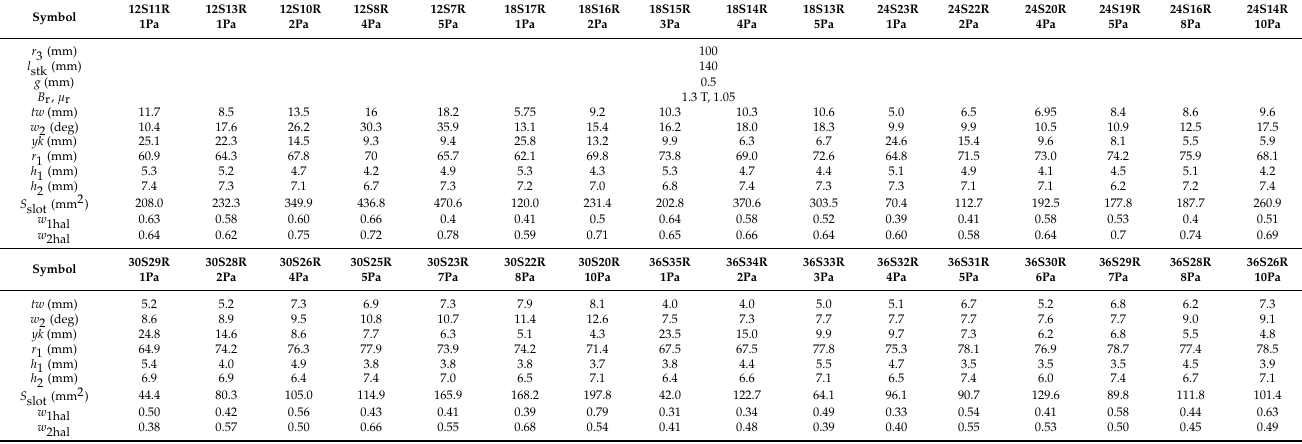
Table 1. Parameters of optimized SSDPM machines with different slot/pole number combinations. Symbol